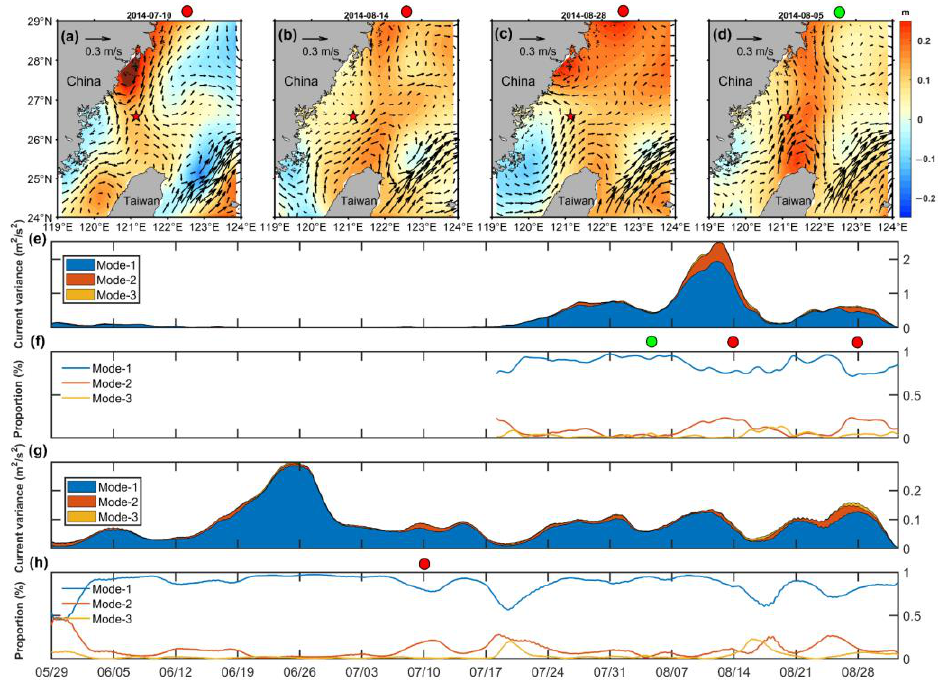
Figure 7. SLA and geostrophic currents during ( a – c ) three eddy periods and ( d ) a calm time. Time series of depth-integrated ( e ) semidiurnal and ( g ) diurnal baroclinic current variance in first three modes (stacked colors) by 14-day moving overlapped EOFs, and their respective proportions of the first eight EOF modes ( f , h ).